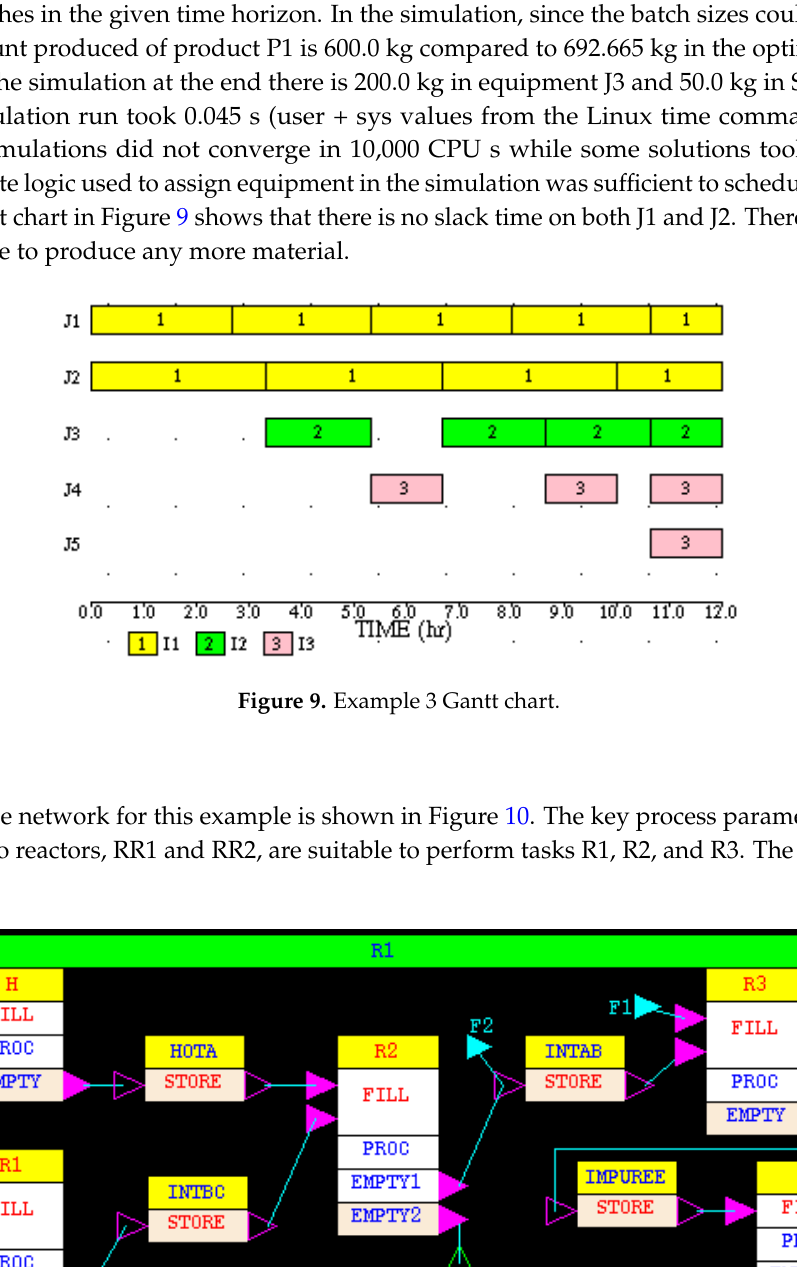
Figure 10. Recipe network for Example 4.